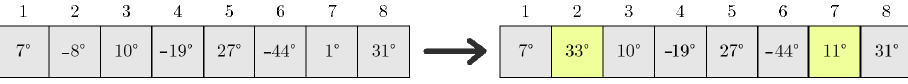
Figure 3. Example of mutation